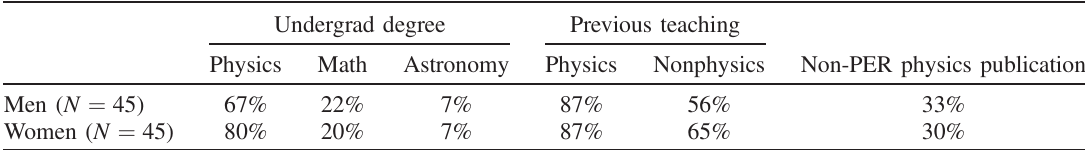
TABLE II. PER graduate student background by gender.